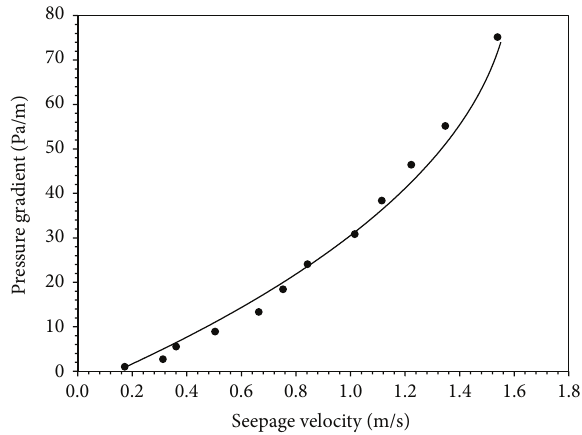
Figure 2: The relationship between pressure gradient and seepage velocity of spheres layer with diameters of 20 cm.